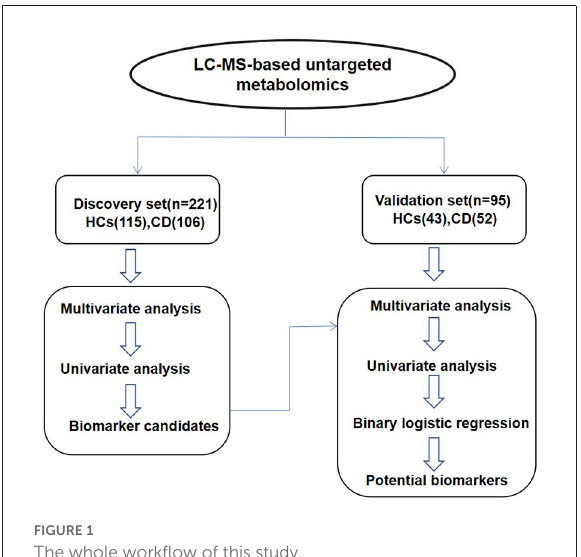
FIGURE1 The whole workflow of this study.